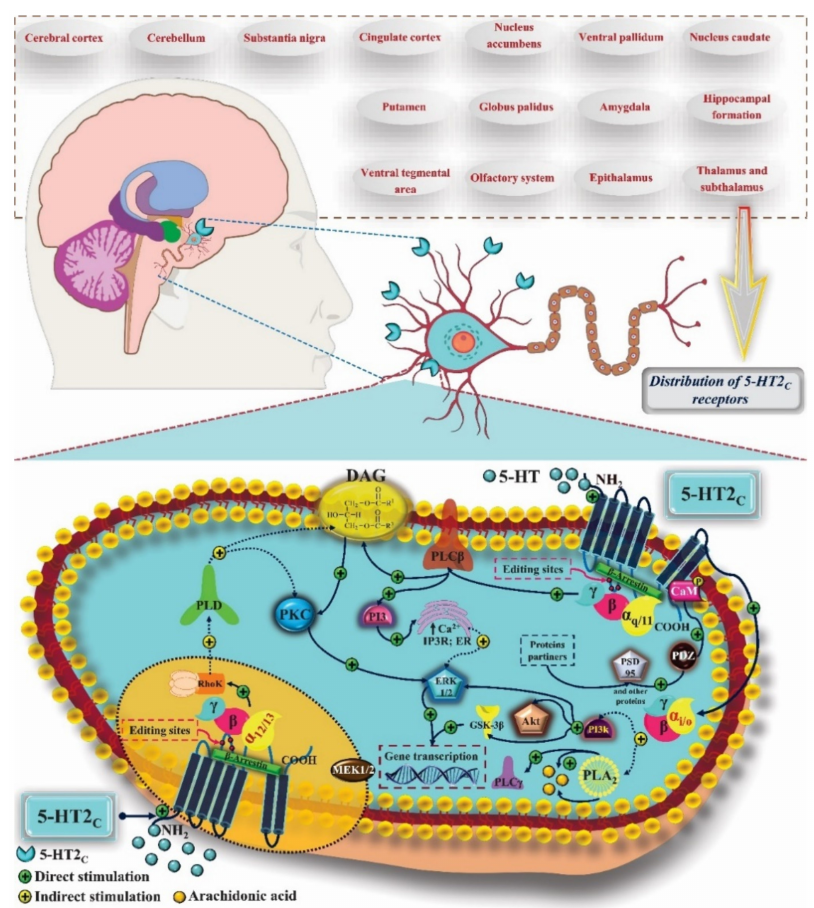
Figure 7. 5-HT 2C receptor signaling. After activation of the 5-HT 2C receptor by 5-HT, the G α q/11 protein is activated and subsequently stimulates phospholipase C (PLC) activity. PLC catalyzes the hydrolysis of phosphatidylinositol-4,5-bisphosphate into inositol 1,4,5-triphosphate (IP3) and diacyl- glycerol (DAG). IP3 diffuses through the cytoplasm and stimulates the release of calcium (Ca 2+ ) from the endoplasmic reticulum and DAG activates protein kinase C (PKC), leading to the phosphorylation of various cellular substrates, which in turn activate several intracellular biochemical cascades. The activation of the 5-HT 2C receptor can also stimulate the activity of enzyme phospholipase A 2 (PLA 2 ), which is responsible for the synthesis of arachidonic acid (causing its release in the intracellular space). The “atypical” coupling represented by the orange circle demonstrates that through the coupling of the G α 12/13 protein, the activation of the 5-HT 2C receptor stimulates phospholipase D (PLD), whose activity converges to PKC activation, which subsequently activates extracellular signal- regulated kinases 1 and 2 (ERK1/2). Another ERK activation pathway is provided through G α i/0 , which induces the phosphatidylinositol-3-kinase (PI3K)/protein kinase B (AKT)/glycogen synthase kinase-3 β (GSK-3 β ) cascade. Finally, this signal transduction system controls genetic transcription [58]. The β -Arrestin protein interacts with 5-HT 2C receptors and creates a steric impediment that blocks the coupling of heterotrimeric G proteins to the receptor, preventing the activation of G α